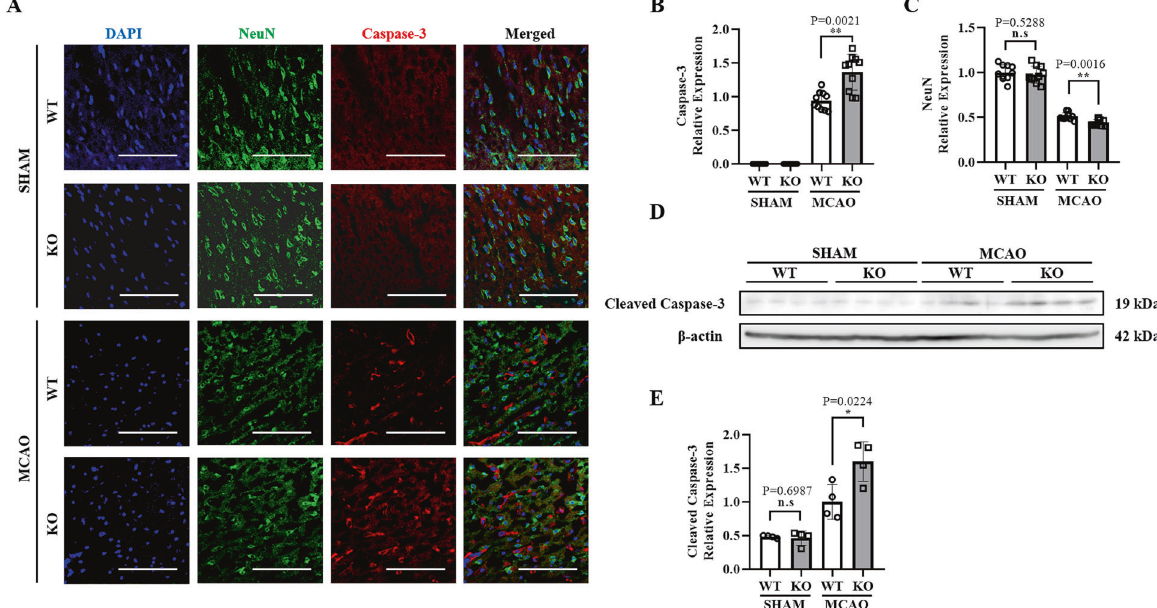
Fig. 3 CRTC1 deletion and miR-132 knockdown aggravate neuron apoptosis. Representative immunostaining images ( A ) and quanti fi cation of Caspase-3 ( B) and NeuN ( C) in CRTC1 and KO brain sections. (Scale Bar, 100 μ m). Representative western Blot image ( D ) and quanti fi cation ( E ) of cleaved caspase-3 in CRTC1 KO and WT penumbra